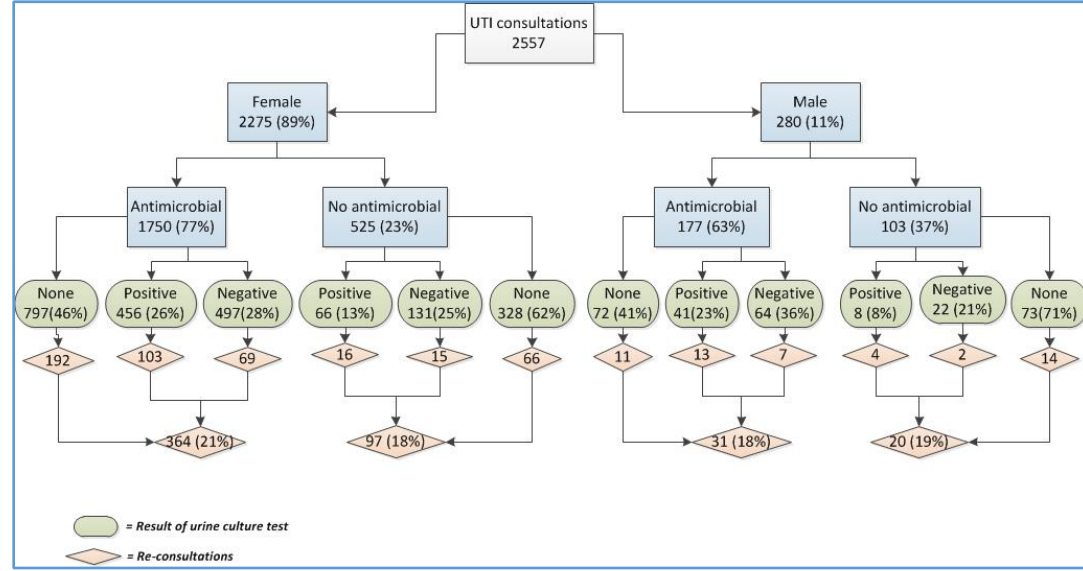
Figure 2. Flow chart of the reconsultations according to gender, antimicrobial treatment, and culture results.